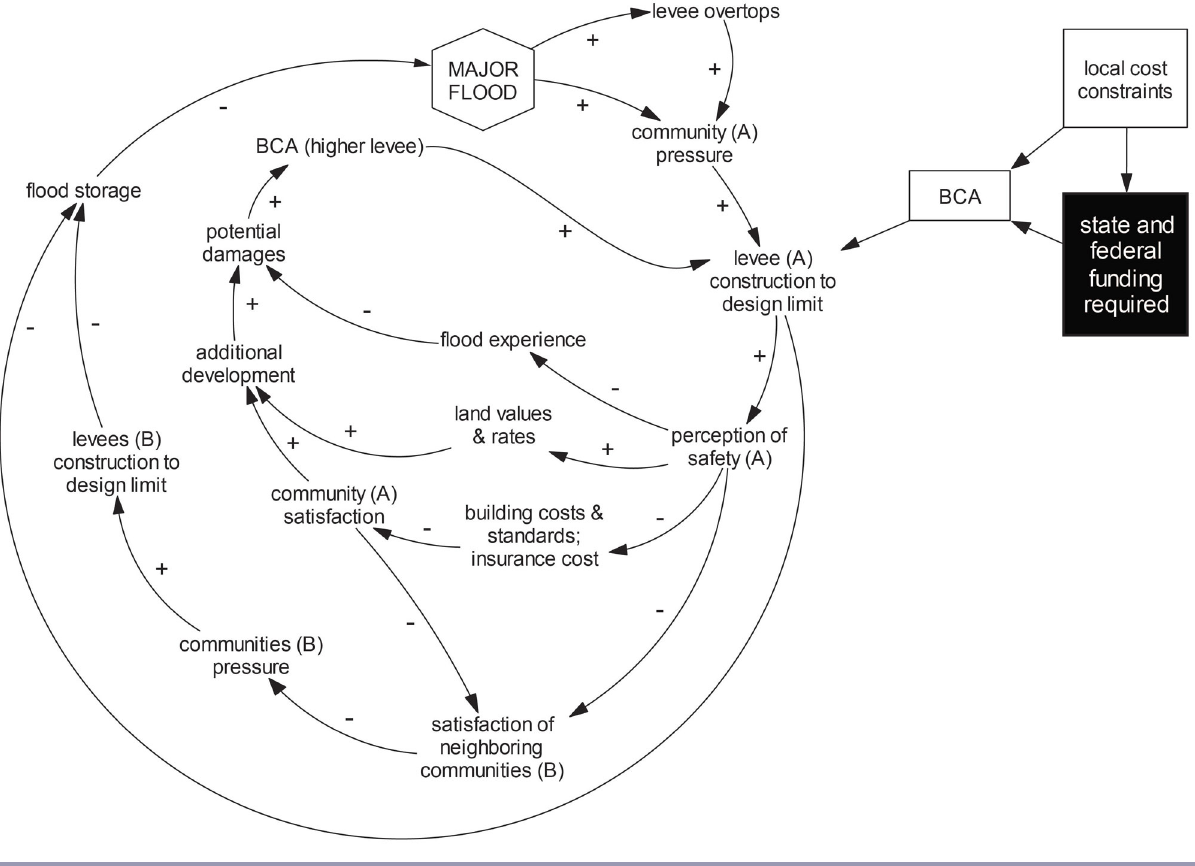
Figure 7 looks at options to alter levee paradox feedbacks. In this example, levees are used as a temporary solution to